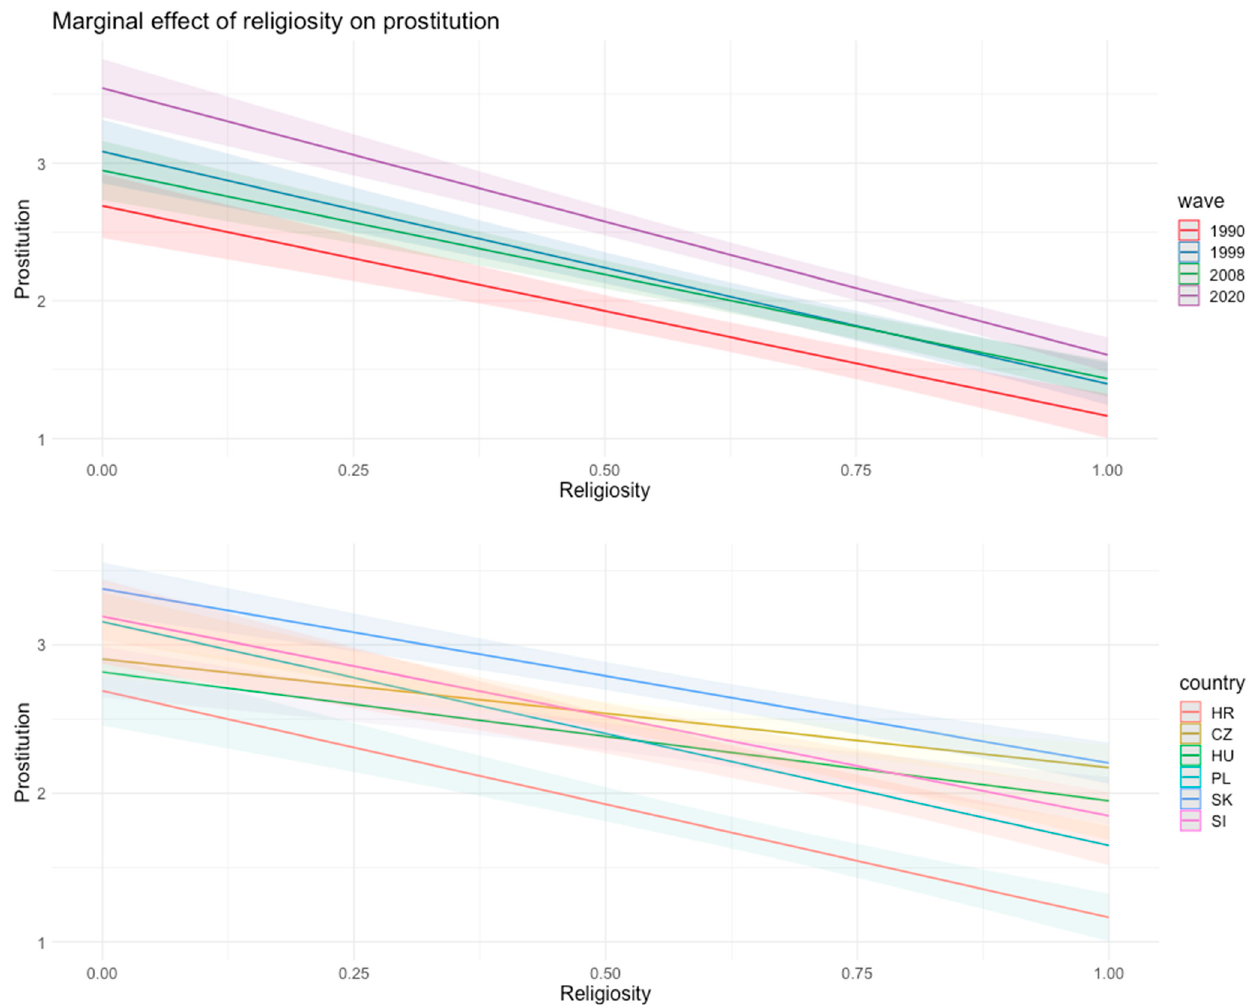
Figure 2. Predicted marginal means of prostitution per waves and countries on different level of religiosity. A more detailed regression table with the interaction effects is available in the Supplementary Materials.